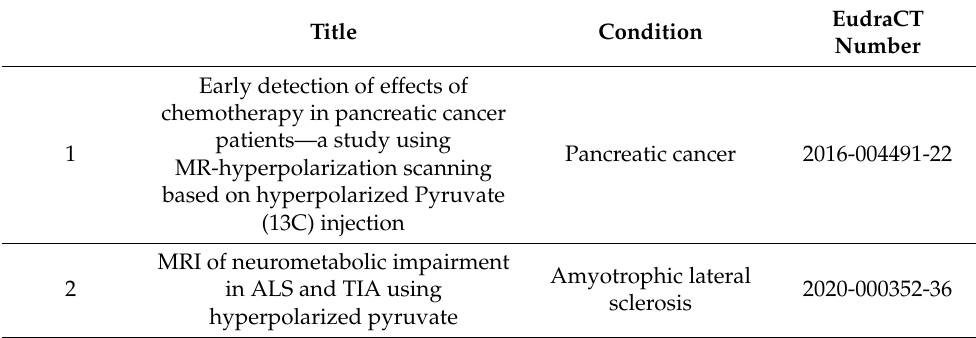
Table A3. Studies reported to EudraCT for clinical trials of hyperpolarized carbon-13